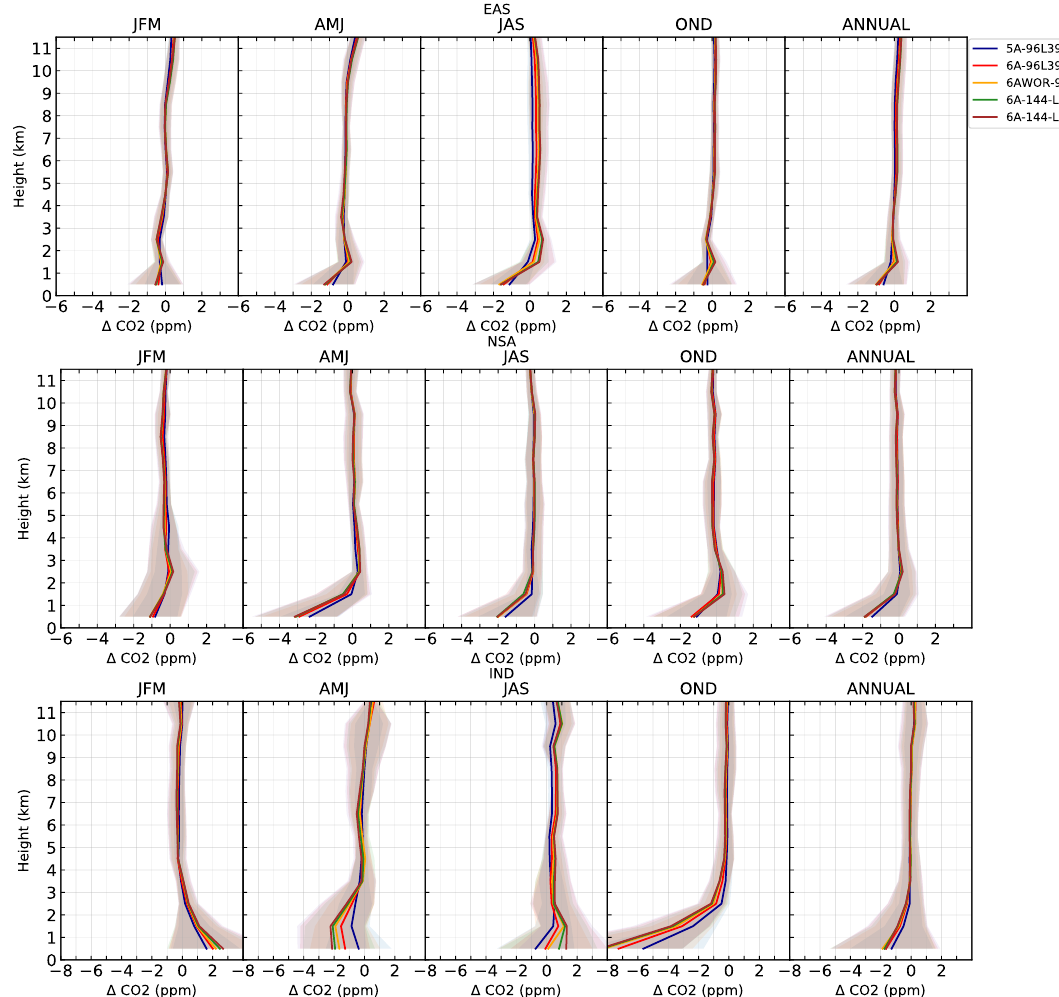
Figure 12. Same as for Fig. 11 over East Asia (EAS), northern Southeast Asia (NSA) and greater northern India